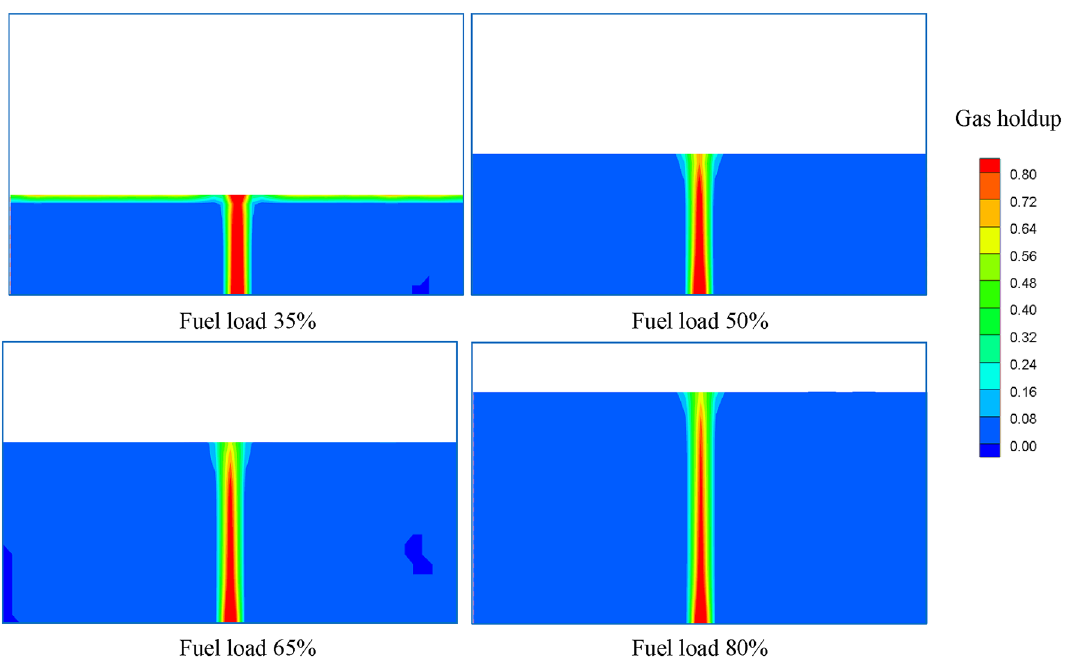
Figure 13. Gas holdup distributions at different fuel